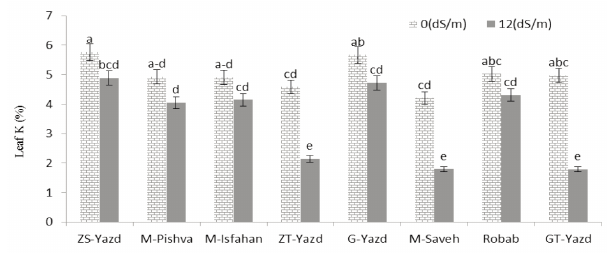
Fig. 11 ­ The interaction effects of water salinity and pomegra­ nate cultivars on leaf potassium